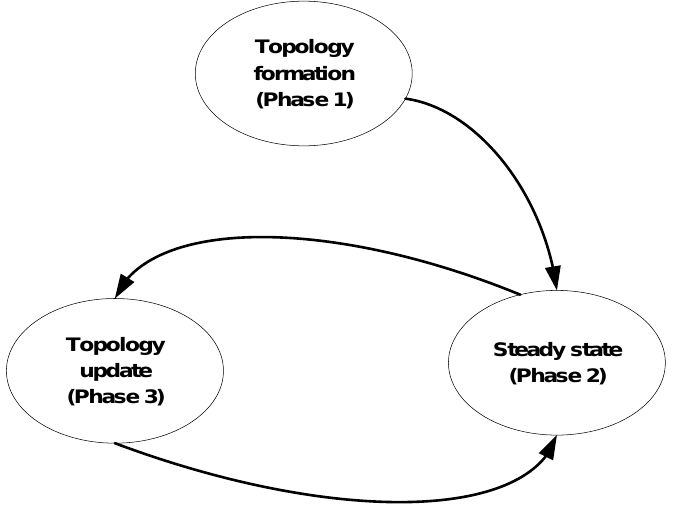
Figure 6. Transitions of different phases of the proposed